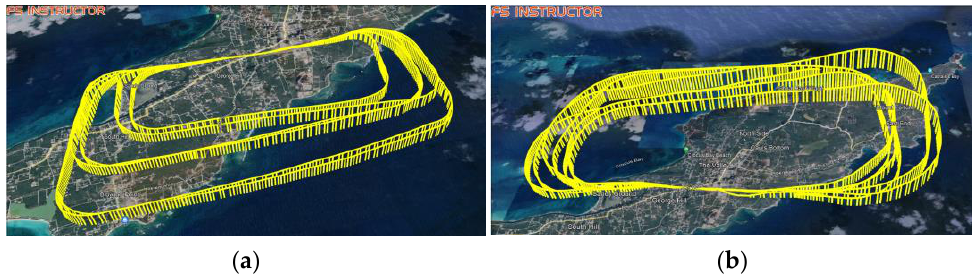
Figure 2. The aerodrome circuits performed during test flights: ( a ) piston engine airplane, Pilot no.1; ( b ) very light jet airplane, Pilot no. 3.